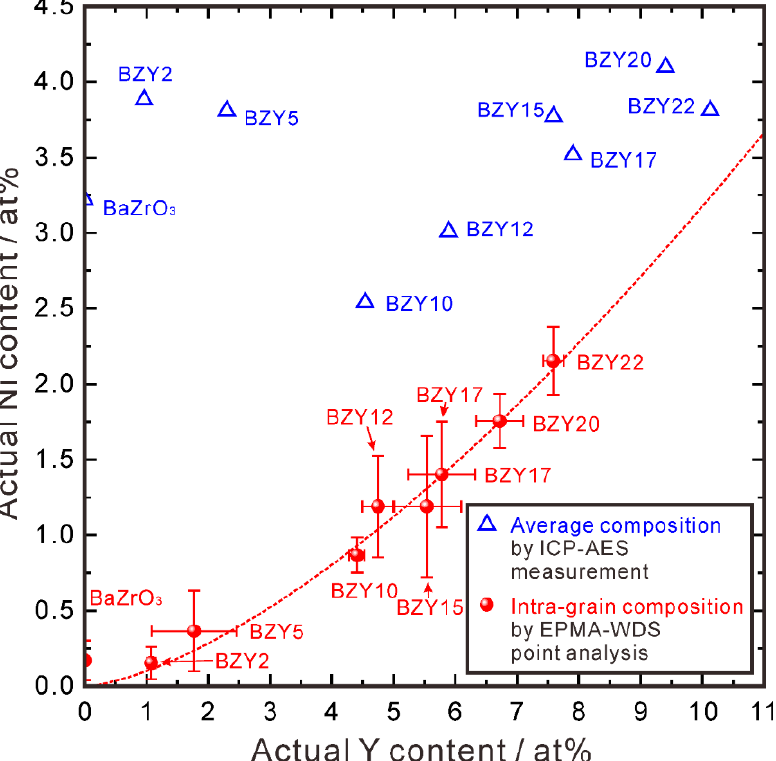
Figure 9. Relationship between the Y and Ni content in the samples with the nominal composition of BaZr 1 − x Y x O 3 −δ -2 wt % NiO ( x = 0, 0.02, 0.05, 0.1, 0.12, 0.15, 0.17, 0.20, 0.22) samples, which were sintered at 1500 ° C in oxygen for 10 h. Both the average compositions determined by ICP-AES measurement, and those of intra-grain determined by EPMA-WDS point analysis were plotted. In the figure, the nominal composition of BaZr 1 − x Y x O 3 −δ were expressed as BZY(100 × x ) in short. The standard deviation ( σ ) was used for drawing the error bars. To verify the reliability of the difference in the composition determined by EPMA-WDS and ICP-AES analyses, EPMA-WDS area analyses were performed to measure the composition of four different square areas (100 μ m × 100 μ m) of BZY12-2 wt % NiO. The average cation ratio of Y and Ni is 5.89% and 2.69%, respectively, very close to 5.90% and 3.00%, respectively.